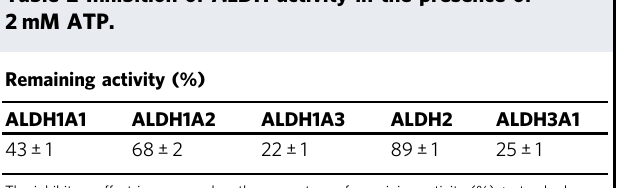
The inhibitory effect is expressed as the percentage of remaining activity (%) ± standard deviation, after 5-min pre-incubation in the absence of cofactor. n = 2, technical replicates for each isoform. Standard activity was measured at saturating concentrations of hexanal in the corresponding reaction buffer, containing 2mM ATP and concentrations of the corresponding cofactor near K m